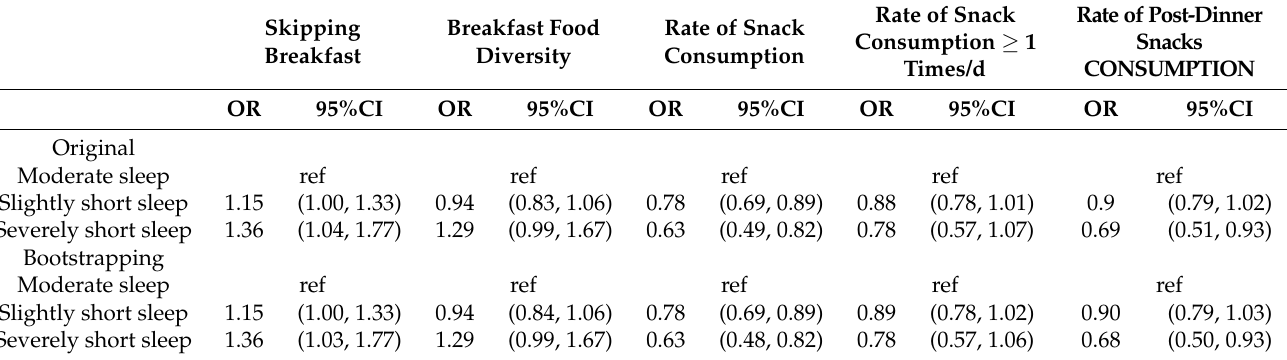
Table 3. Logistic regression of breakfast skipping and food diversity with sleep